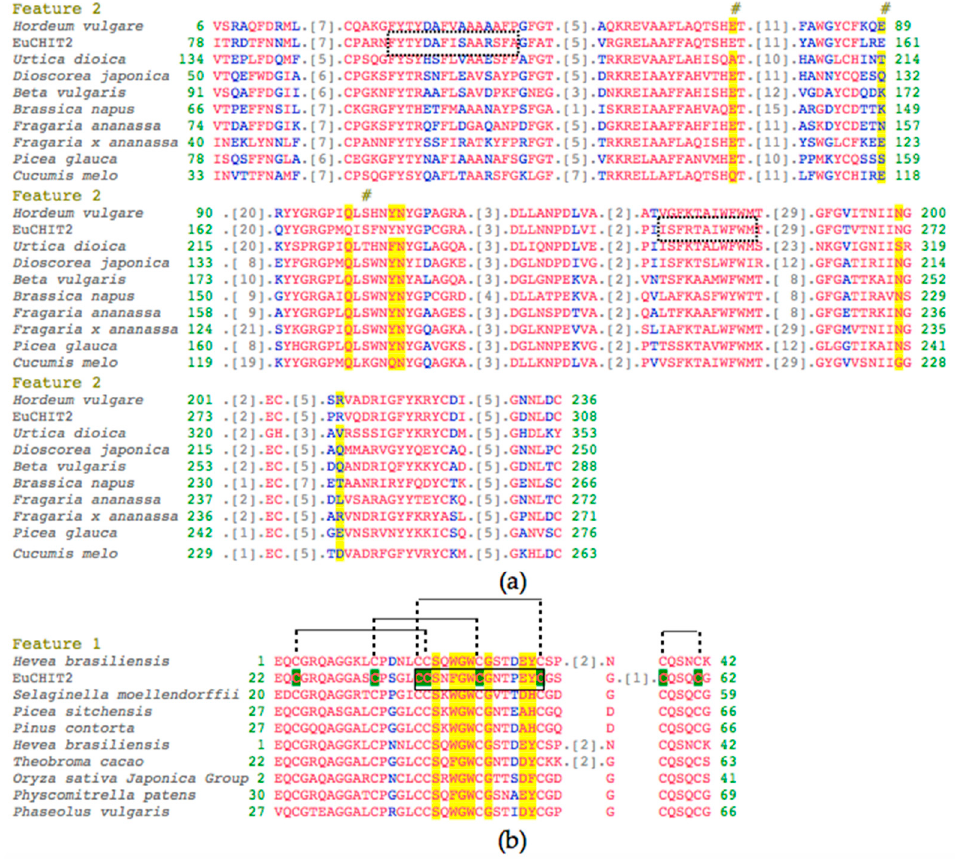
Figure 1. Alignment analysis of EuCHIT2 with other organisms. ( a ) Alignment of deduced amino acid sequence of EuCHIT2 with family 19 chitinases different organisms. The two chitinase family 19 signature sequences FYTYDAFISAARSFAGFA (95–117 aa) and ISFRTAIWFWM (221–231 aa) were surrounded with imaginary frames; ( b ) alignment of deduced amino acid sequence of EuCHIT2 with ChtBD_CH19_hevein (a hevein protein) of other organisms. The chitin recognition domain signature sequence CCSNFGWCGNTPEYC was surrounded with black frame and the eight “C” residues highlighted in green are the conserved cysteine residues that can form four disulfide bonds in the chitin-binding region of EuCHIT2. The species shown in the figure are: 2BAA ( Hordeum vulgare ), P11218.3 ( Urtica dioica ), P80052.2 ( Dioscorea japonica ), and P42820.1 ( Beta vulgaris ); and Q43391 ( Brassica napus ), AAD28733.1 ( Triticum aestivum ), AAF00131.1 ( Fragaria x ananassa ), Q40838 ( Picea glauca ), and AAF64475.1 ( Cucumis melo ); and 1WKX_A ( Hevea brasiliensis ), EFJ22468.1 ( Selaginella moellendorffii ), ABK24218.1 ( Picea sitchensis ), AEF59005.1 ( Pinus contorta ), 1Q9B_A ( Hevea brasiliensis ), Q41596.1 ( Theobroma cacao ), 2DKV_A ( Oryza sativa Japonica Group), XP_001767856.1 ( Physcomitrella patens ), and CAB97002.1 ( Phaseolus vulgaris ) . The red and blue letters are residues in the chitinase domain share high and relatively higher similarity, respectively. The grey number represents the number of amino acid residues that have been omitted. The amino acid residues highlighted in yellow are sugar-binding residues, and the residues under the # markers are catalytic